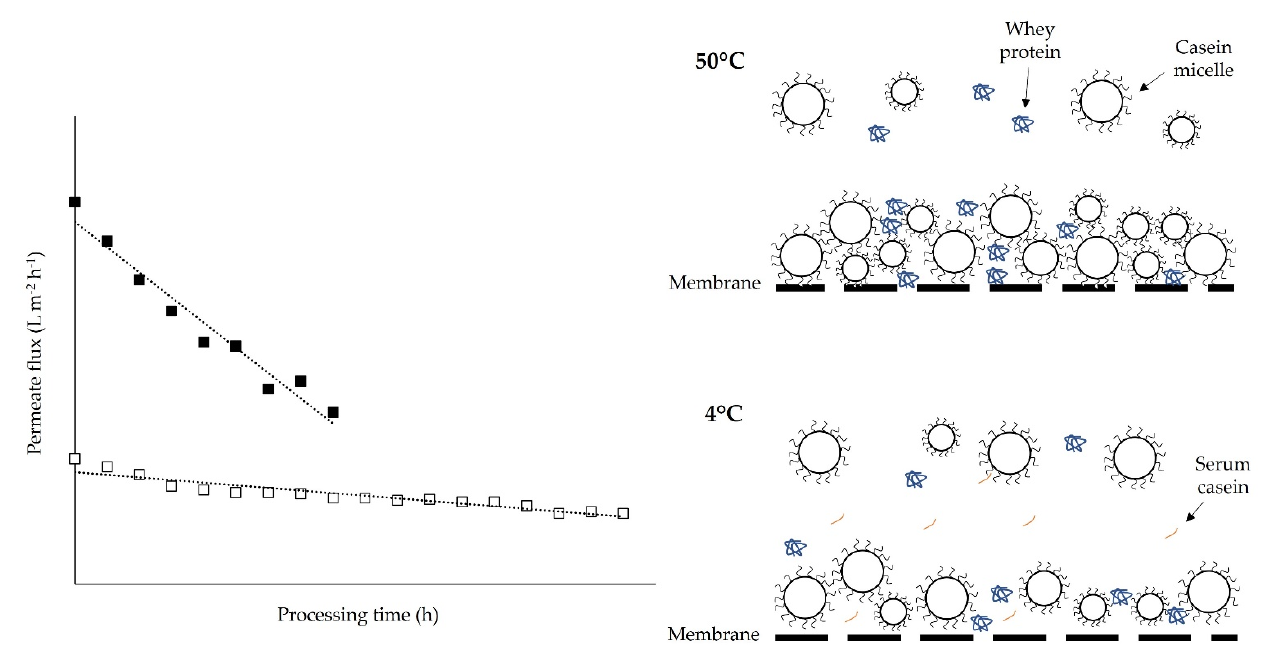
Figure 2. Schematic representation of permeate flux decline during warm (50 ◦ C: (cid:4) ) and cold (4 ◦ C: (cid:3) ) microfiltration of skim milk ( left ; modified from [19], copyright 2017 International Dairy Journal) and differences in compactness of the deposit layer on the membrane surface after MF at the respective temperature ( right ).